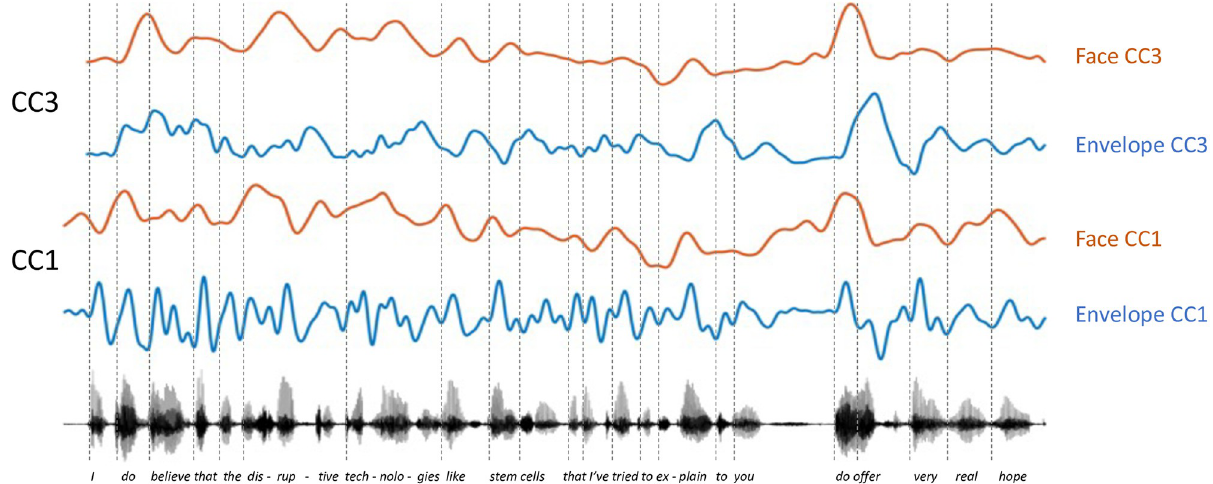
Fig 3. CC1 and CC3 for an example speaker. The CC time series for the speech envelope are shown in blue, and the CCs for the facial landmarks are shown in orange. Vertical lines indicate word onsets. CC1 represents speech envelope fluctuations corresponding to the onset of individual syllables, while CC3 tracks slower variations corresponding to words or